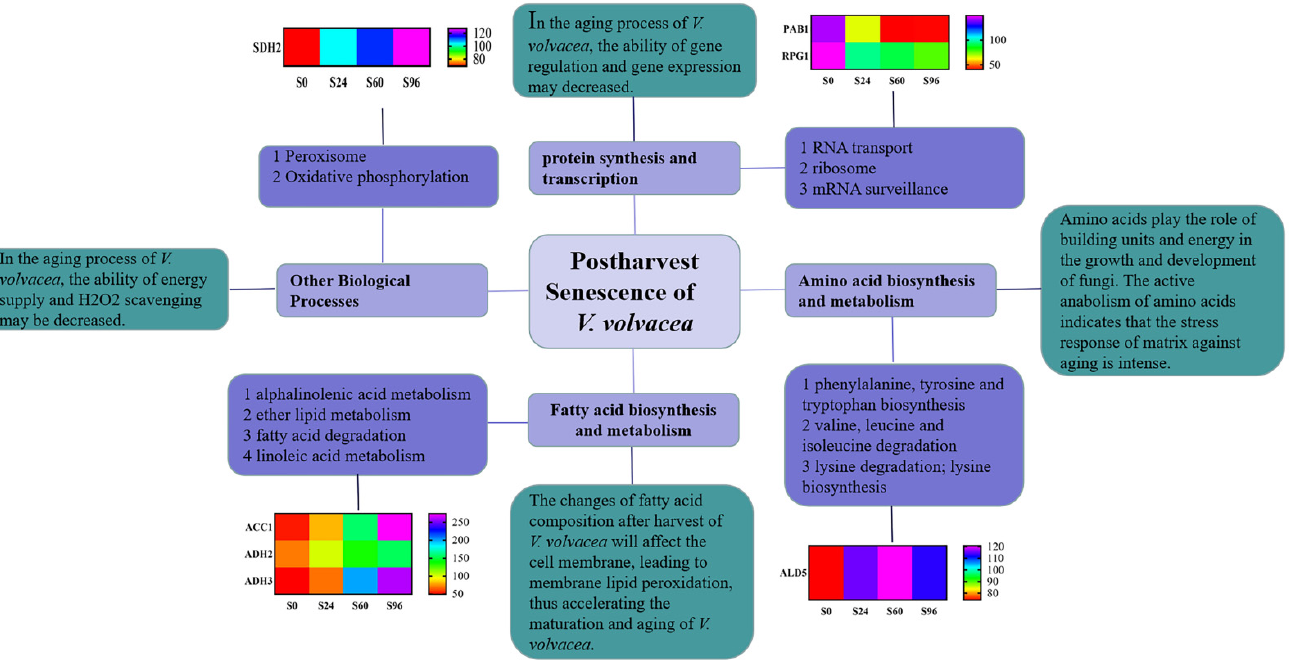
Figure 8. Model of V. volvacea postharvest senescence based on physiological, biochemical, and proteomic changes.